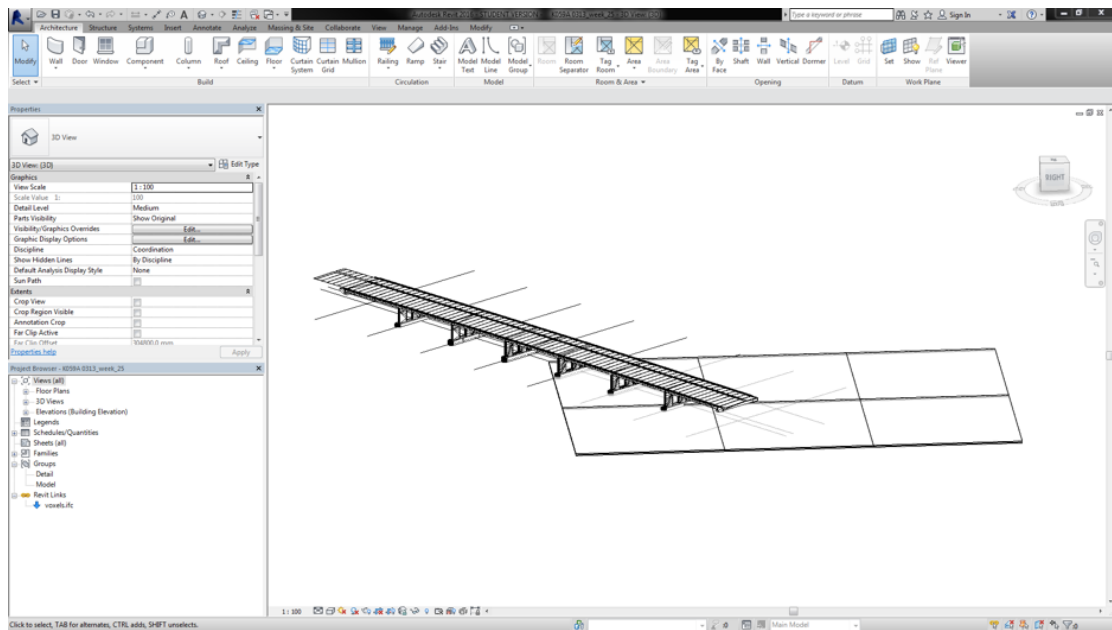
Figure 12. Attempting to put a BIM model of a bridge (provided by VolkerInfra for testing) and the generated GeoTOP voxel